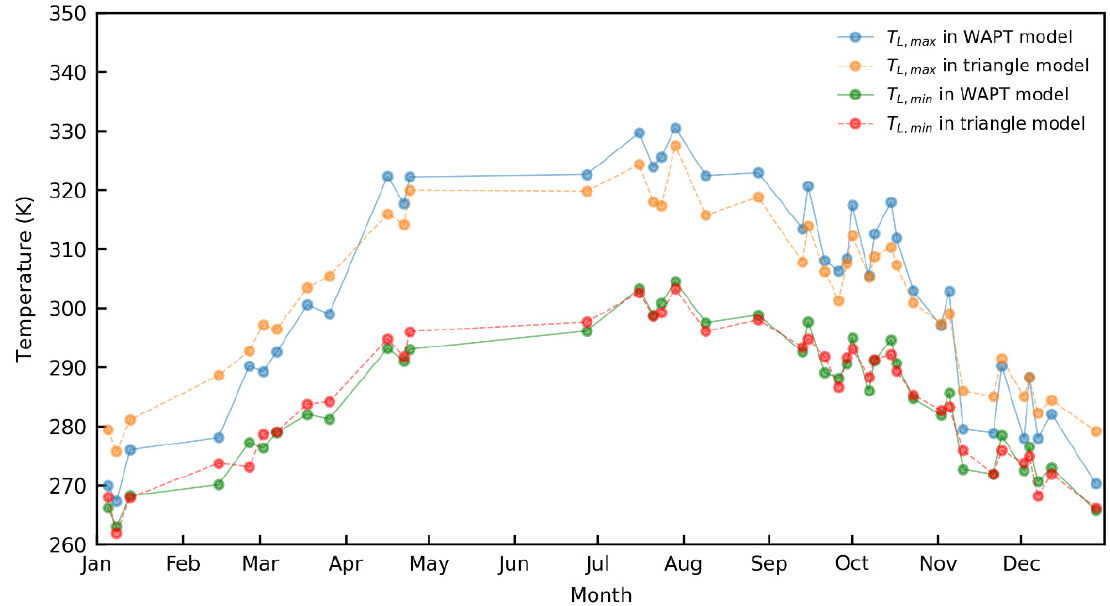
Figure 9. Maximum/minimum temperatures on dry/wet edges from WAPT and triangle models during long-term observation periods from 2013 to 2018.